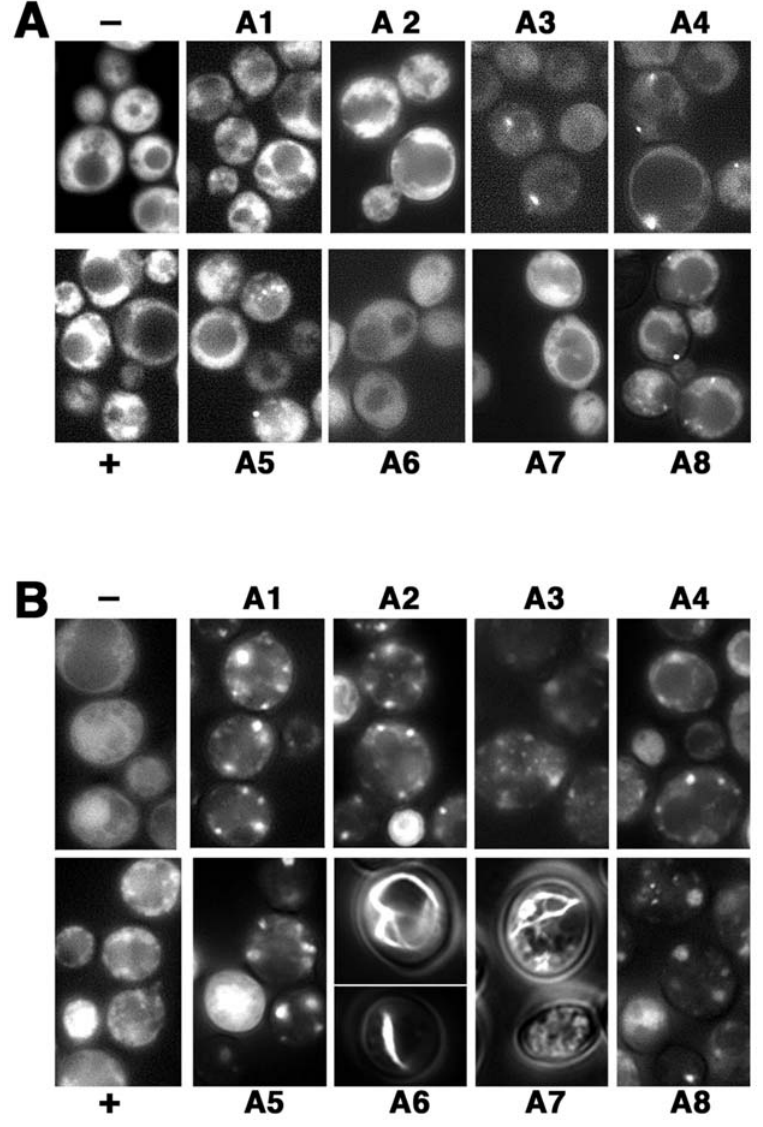
Figure 8. Aggregation of Sup35-GFP in vivo. (A) Fluorescent images of cells from cultures used for the SDD-AGE experiments were taken at the same time cells were processed for SDD-AGE. (B) Images of cells from the same cultures after incubation for an additional six days at 25 u in the same medium. Strains A1-A8 are indicated, + and – are wild type 779-6A [ PSI + ] and [ psi 2 ] controls.